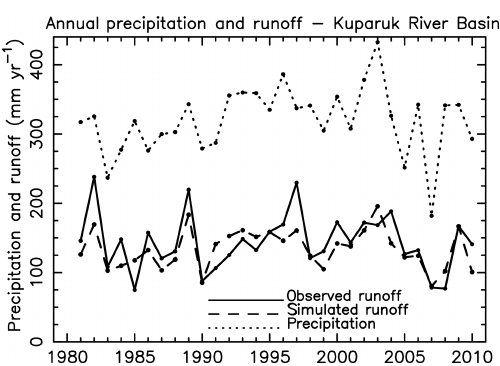
Figure 4. Annual total P from the adjusted MERRA (MERRA*, Sect. 2.2) and simulated and observed R (mmyr − 1 ) for the Kuparuk River basin for the simulation period 1981–2010.